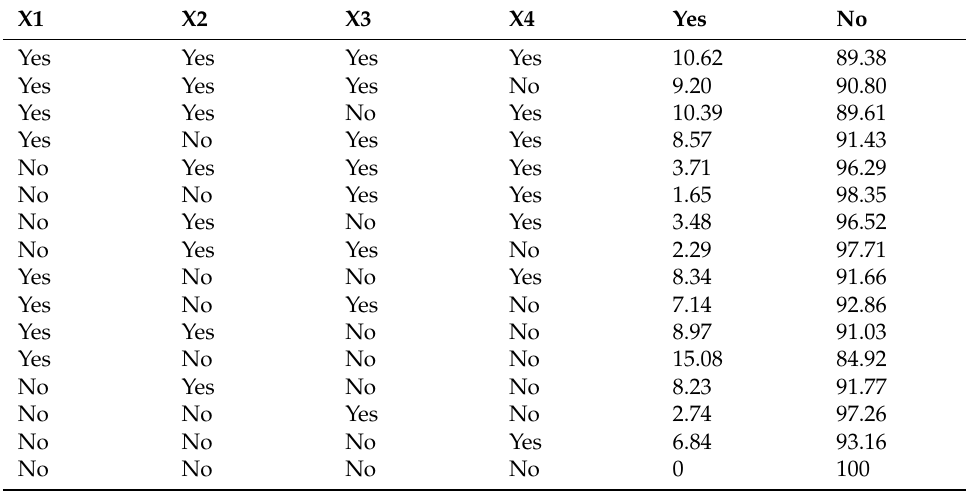
Table A4. Conditional probability of node M1.